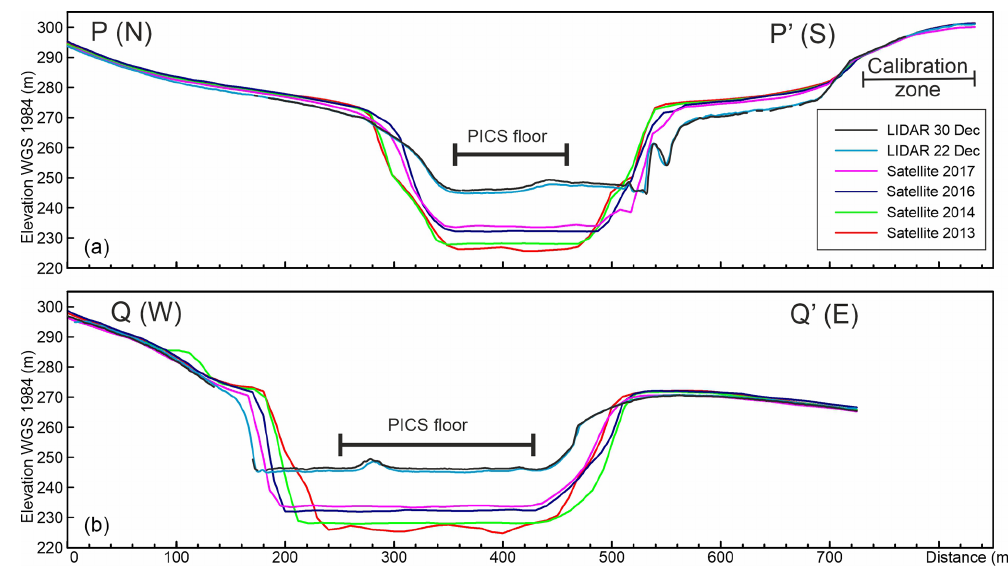
Figure 7. Profiles of surface elevation changes over the PICS structure (locations of P–P (cid:48) and Q–Q (cid:48) shown in Fig. 6). The reference elevation area (Fig. 3a) was used to calibrate the mean vertical shift applied to each satellite-derived REMA strip DEM (2013 + 1 . 93m, 2014 + 0 . 87m, 2016 + 3 . 12m, 2017 + 1 . 39m). The 2019 lidar profiles are un-adjusted. The “PICS floor” region was used to calculate the mean elevation of the base of PICS plotted in Fig. 8. Note the block collapse in the 2019 lidar data (a) and the formation of a new ice cliff.